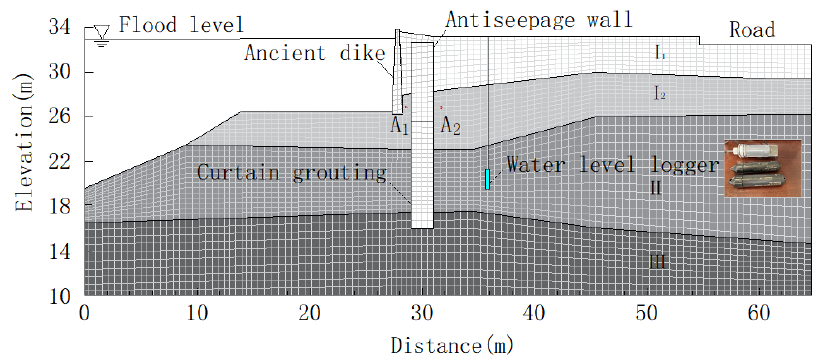
Figure 11. Numerical model of Lanxi ancient riverbank with antiseepage wall.